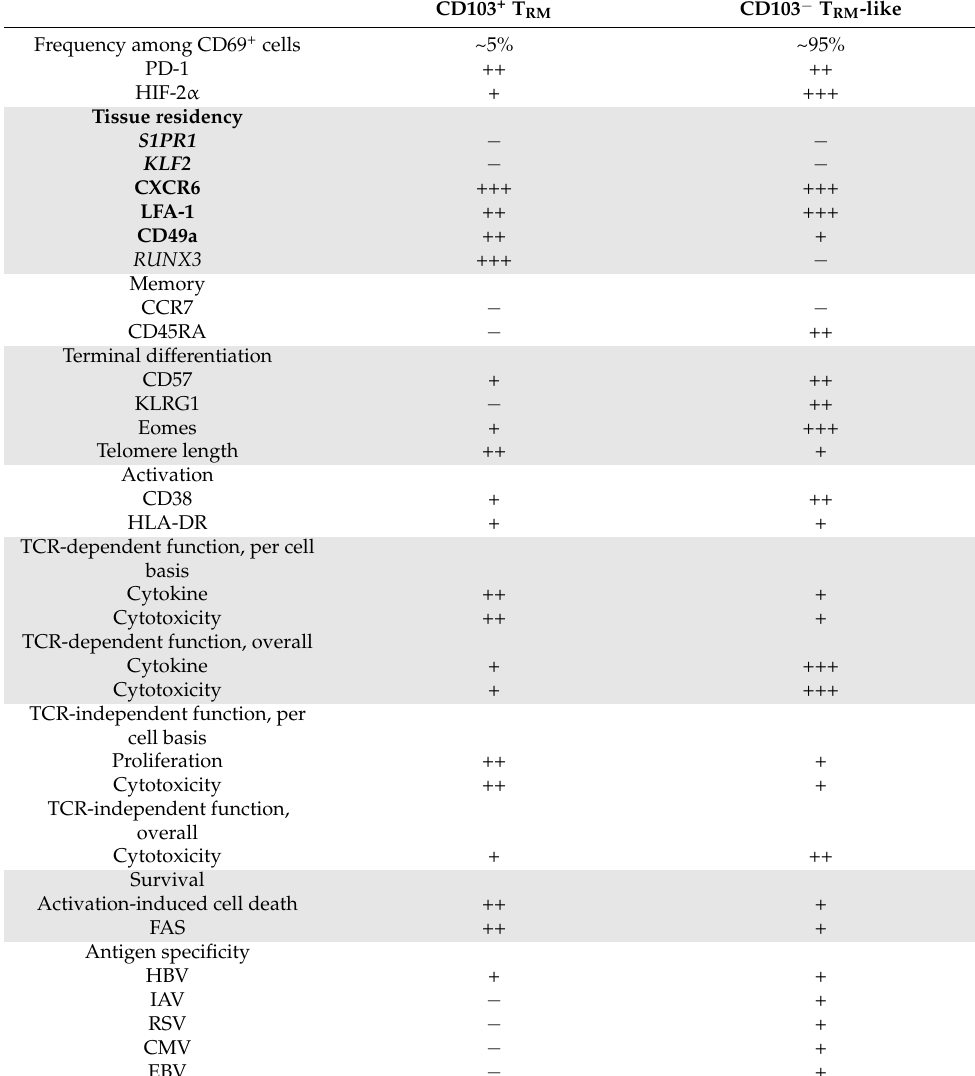
Table 1. Comparison of the CD103 + and CD103 − subpopulations among human liver-resident CD69 + CD8 + T